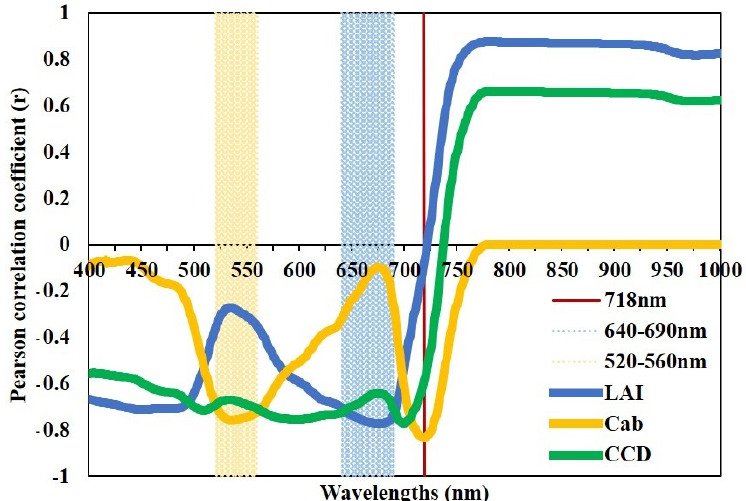
Figure 2. The Pearson correlation coefficient between simulated spectral reflectance and vegetation parameters.